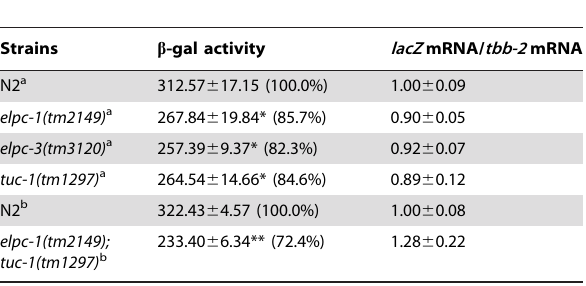
Table 1. Lack of Wobble Uridine tRNA Modification Affects Translation